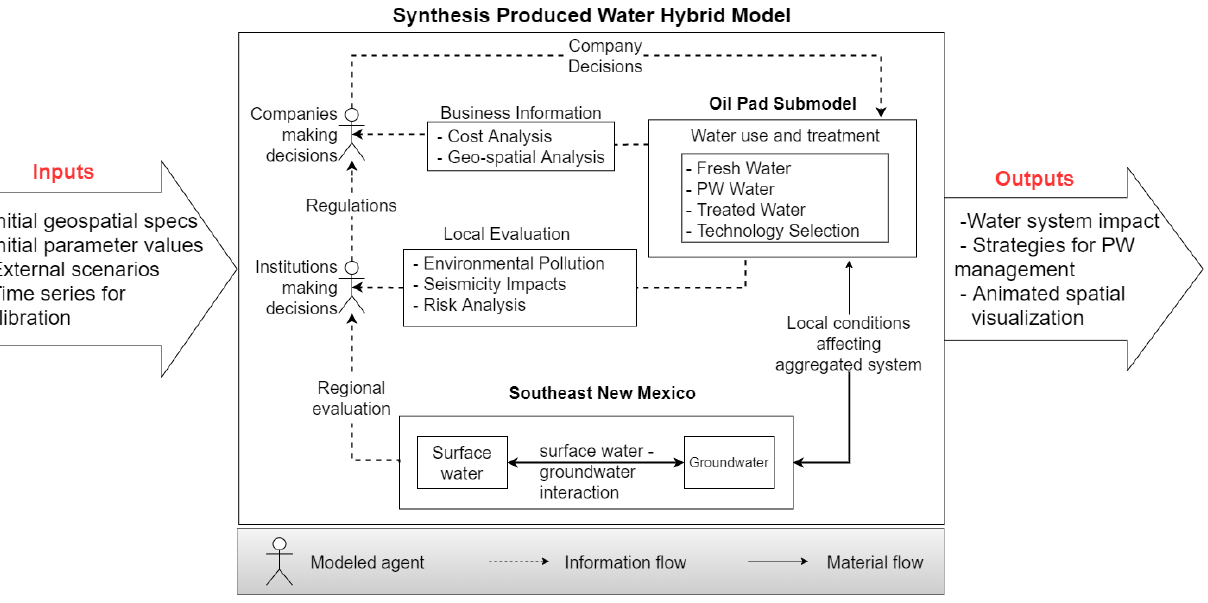
Figure 3. Integrated conceptual framework for the synthesized produced-water hybrid